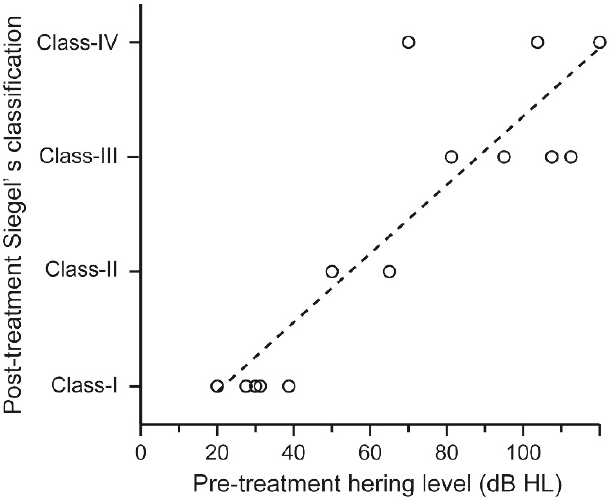
Figure 1. Hearing prognosis of patients who developed sensorineural hearing loss associated with COVID-19. The hearing prognoses of 18 patients who developed sensorineural hearing loss associated with COVID-19 were plotted according to their average pre-treatment hearing thresholds. Their pre- treatment hearing levels were associated with their hearing prognoses, which showed upward trend from Class-I to Class-IV groups with statistically significant difference (linear regression analysis, R = 0.88, p <